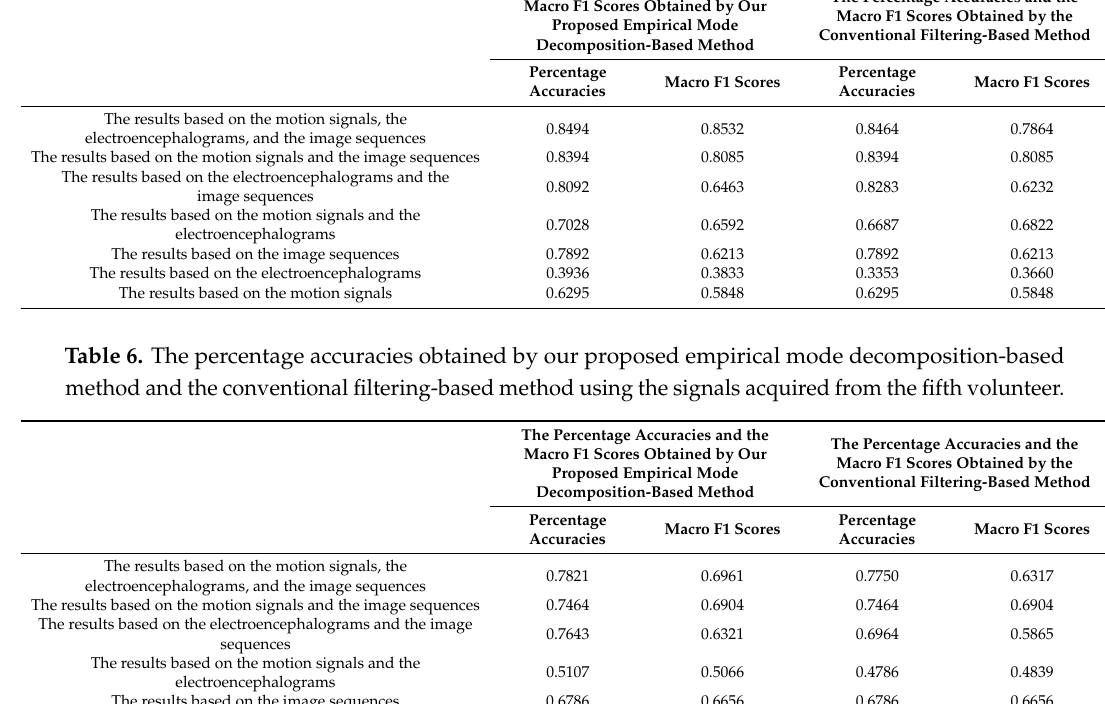
Table 5. The percentage accuracies and the macro F1 scores obtained by our proposed empirical mode decomposition-based method and the conventional filtering-based method using the signals acquired from the fourth volunteer.